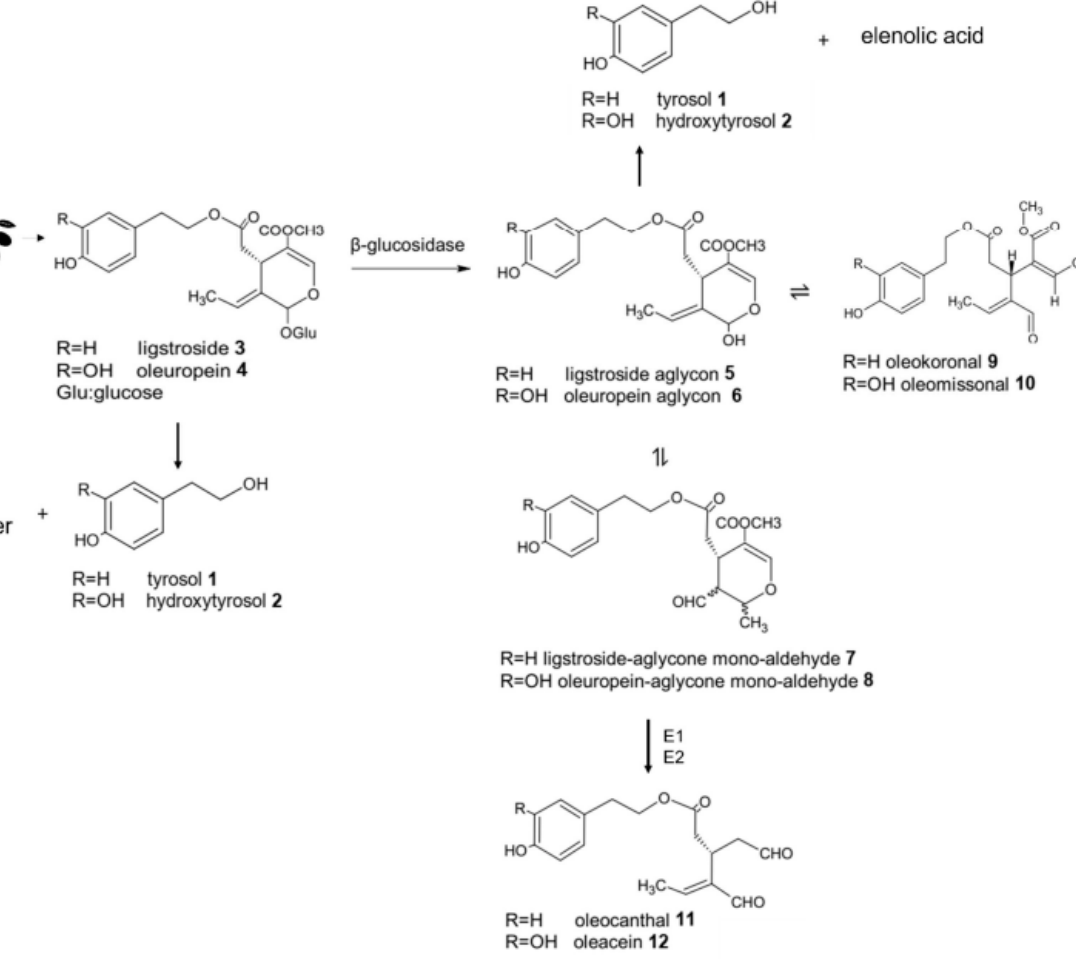
Figure 1. Formation pathway of some phenolics in VOO (biosynthetic pathway of secoiridoids), according to the information available in the literature [46].